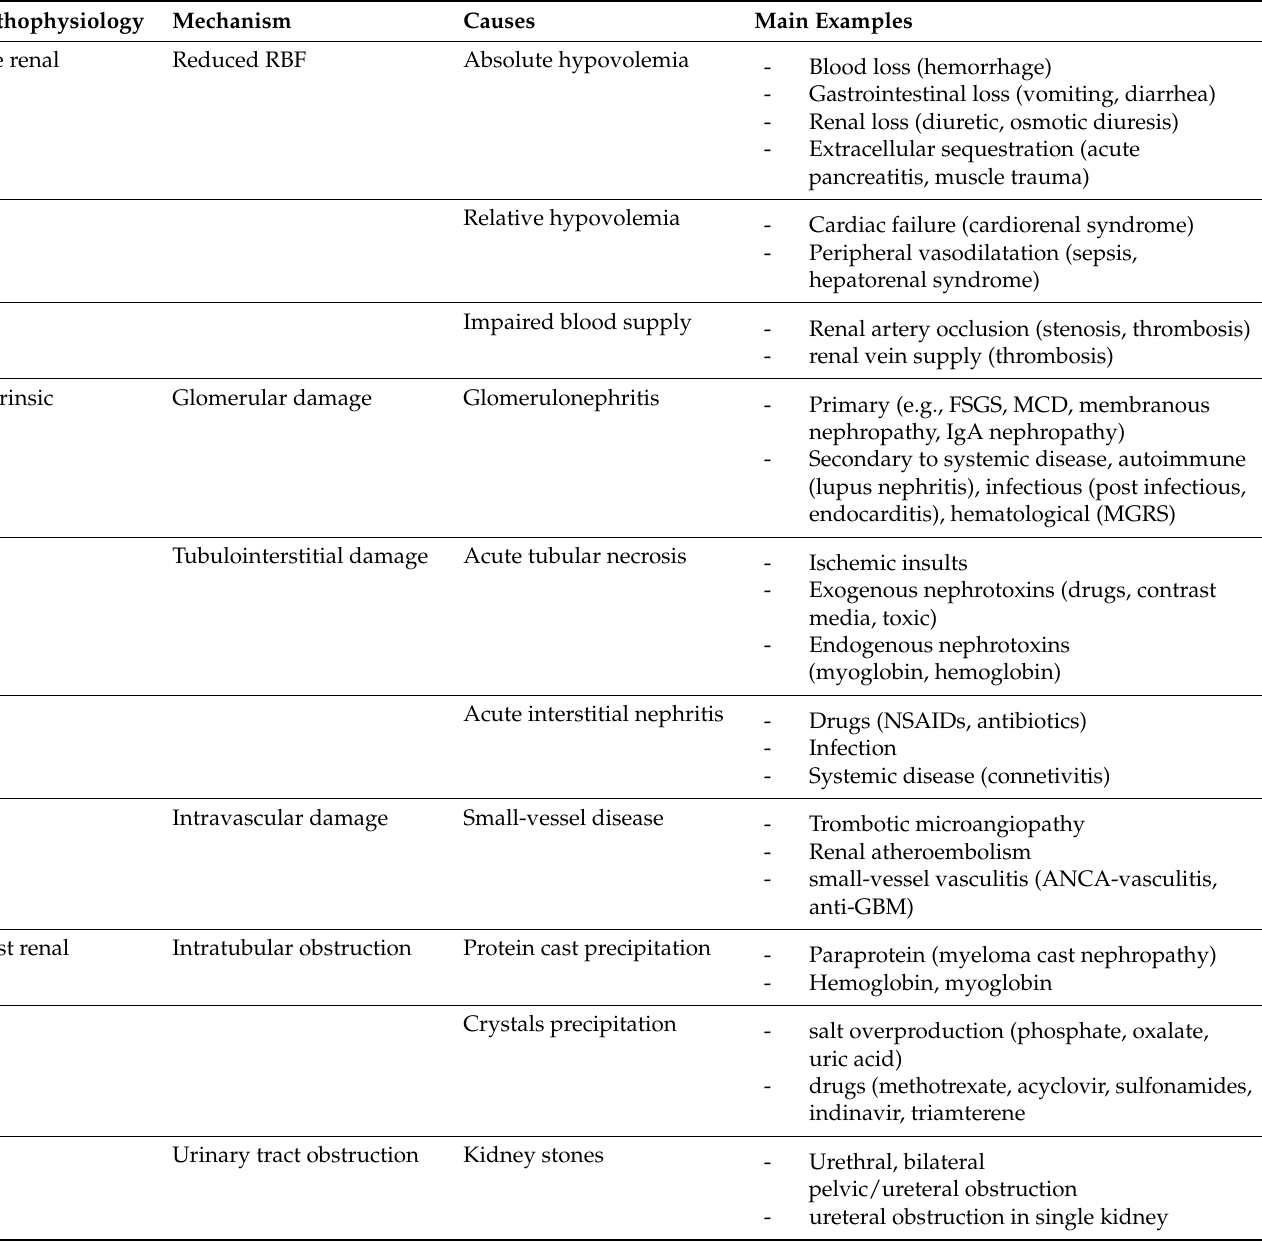
Table 1. Ethiopatogenesis of